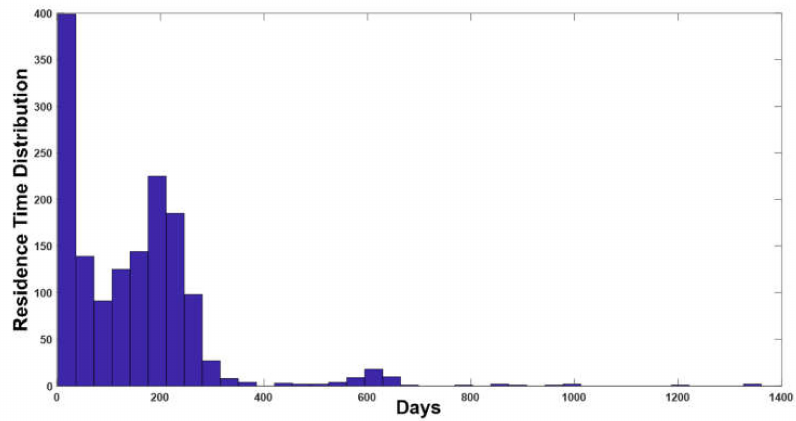
Figure 4. Residence time distribution (RTD): Two main peaks centered between 190 and 210 days, and around 600 days can be observed. The typical exponential decreasing peaks support a stochastic resonance phenomenon in the dynamics of AOD [16]. This represents an example of estimate of the residence times (the lapsed times) between the two selected amplitude-crossing thresholds τ u = 0.2 and τ d = −